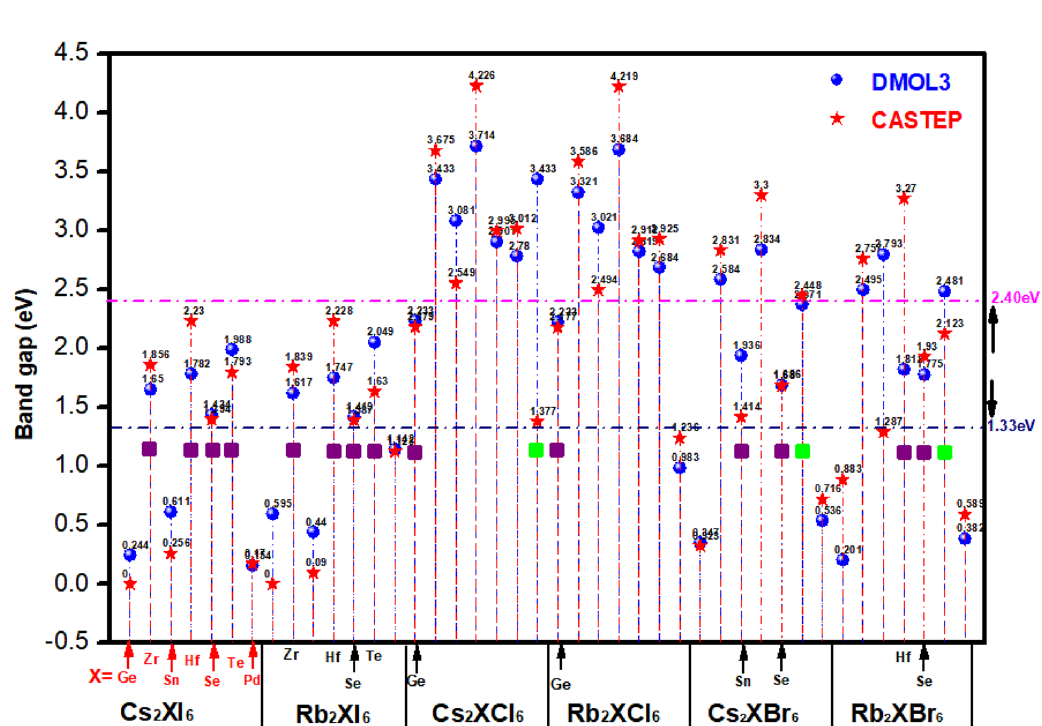
Figure 5. The value of bandgaps for A 2 BX 6